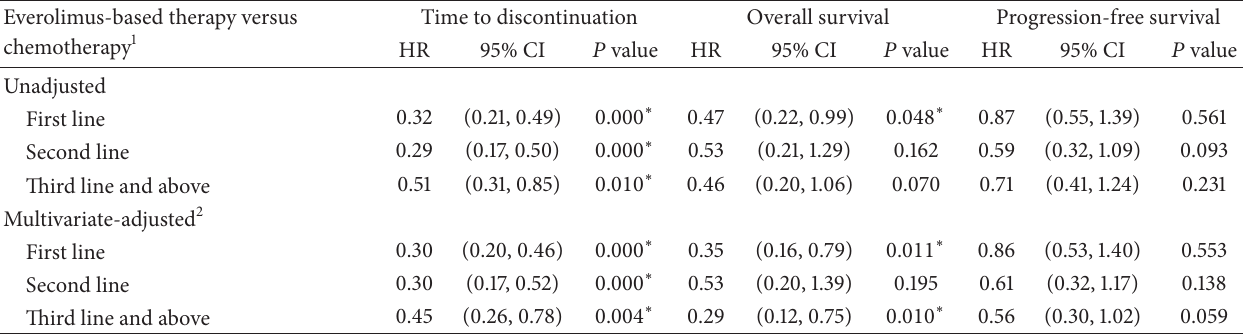
Table 3: Hazard ratios (HRs) comparing everolimus-based therapy and chemotherapy by line of therapy.